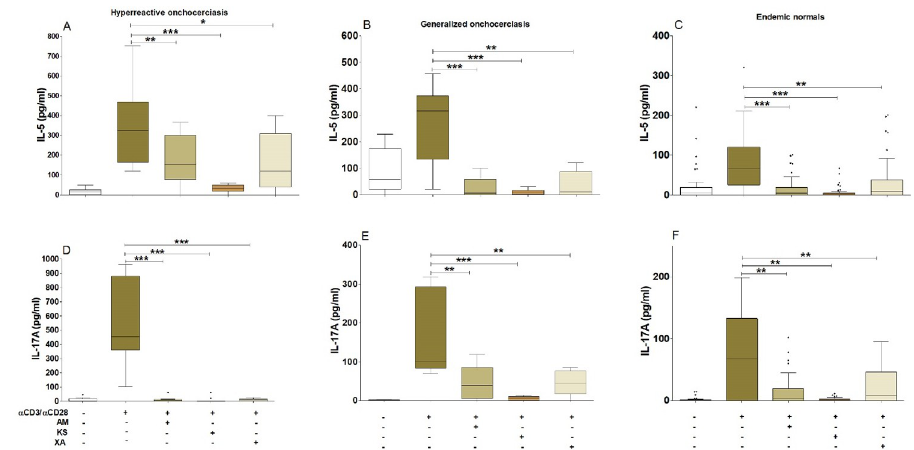
Fig 3. Inhibition of IL-17A and IL-5 induction in HO, GEO and EN individuals by the hydro-ethanolic extracts of Aframomum melegueta , Khaya senegalensis or Xylopia aethiopica . PBMCs (2x105 cells) isolated from EN (n = 13), GEO (n = 15) and HO (n = 6) individuals were activated with α CD3 (12.5 μ g /well) / α CD28 (2.5 μ g / well) in the presence or absence of Aframomum melegueta (AM), Khaya senegalensis (KS) or Xylopia aethiopica (XA) extracts (200 μ g / mL). Box whiskers (tukey) with outliers show levels of IL-5 (A, B and C) and IL-17A (D, E and F) after co- culture with α CD3 / α CD28 in presence or absence of AM, KS or XA. Asterisks show statistical differences (Mann- Whitney-U test) between the groups indicated by the brackets ( � p < 0.05, �� p < 0.01, ��� p < 0.001).